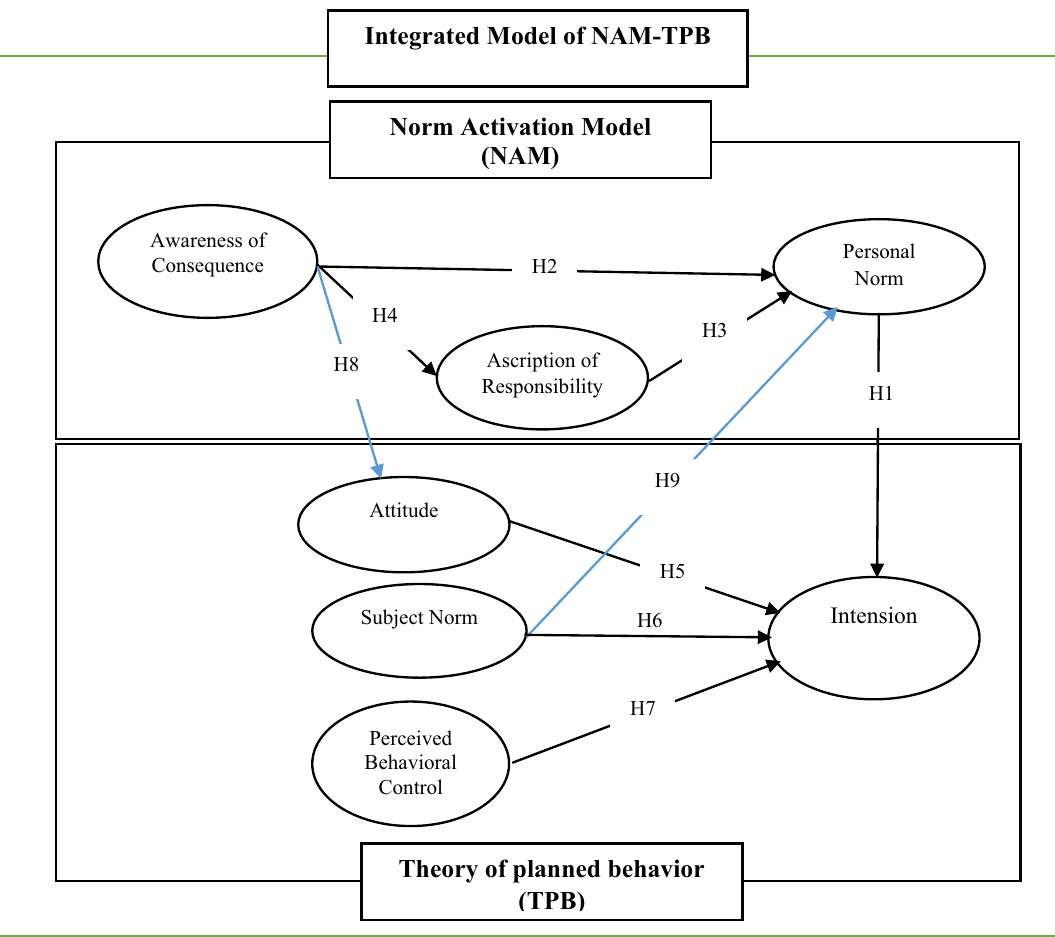
Figure 1. Shows the interaction between these hypothetical positions across the two